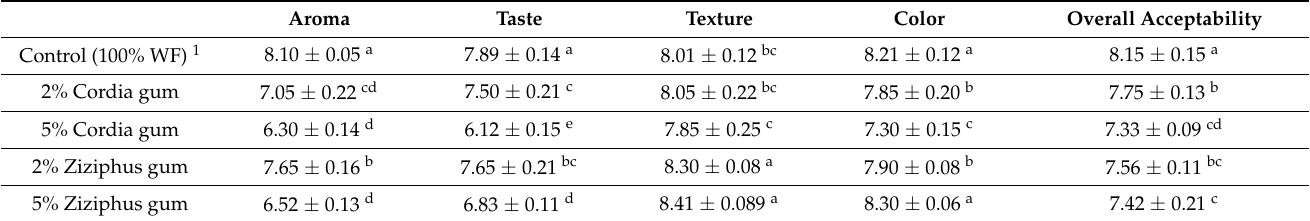
Table 5. Sensory evaluation of